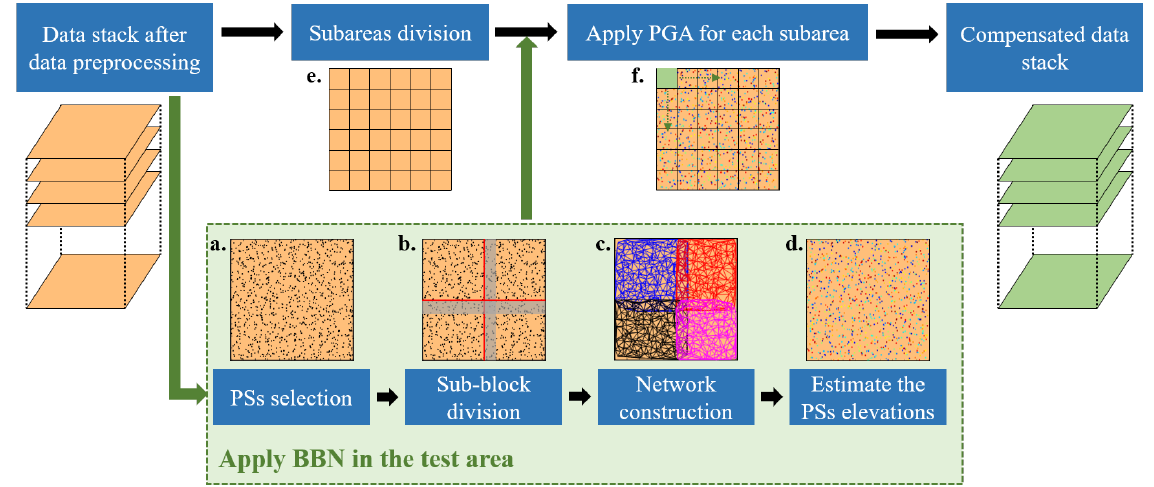
Figure 2. The workflow of the BBN-PGA